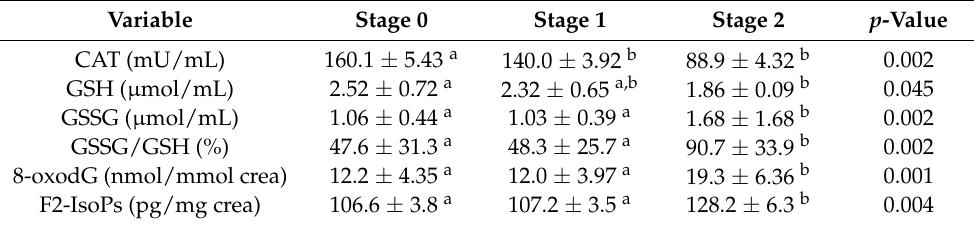
Table 2. Study of oxidative stress markers in CRC patients according to tumor stages.